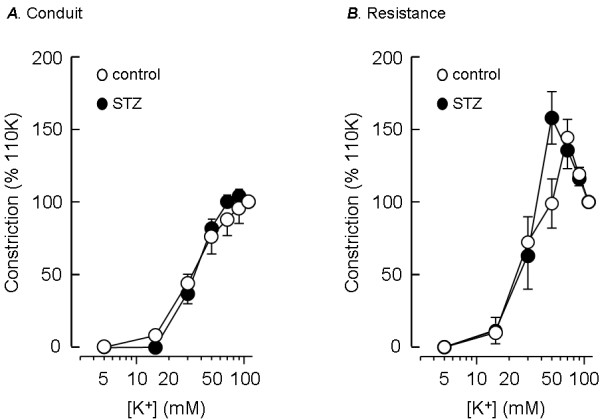
Resistance of depolarisation-induced pulmonary artery constriction to STZ-induced diabetes. Constrictor responses to increasing concentrations of extracellular K+, measured as a percentage of the response to 110 mM K+, in conduit (A) and resistance-sized (B) intrapulmonary arteries from STZ-treated (solid circles) and age-matched control (open circles) rats. Data plotted are mean ± s.e.m. of 8–10 animals.